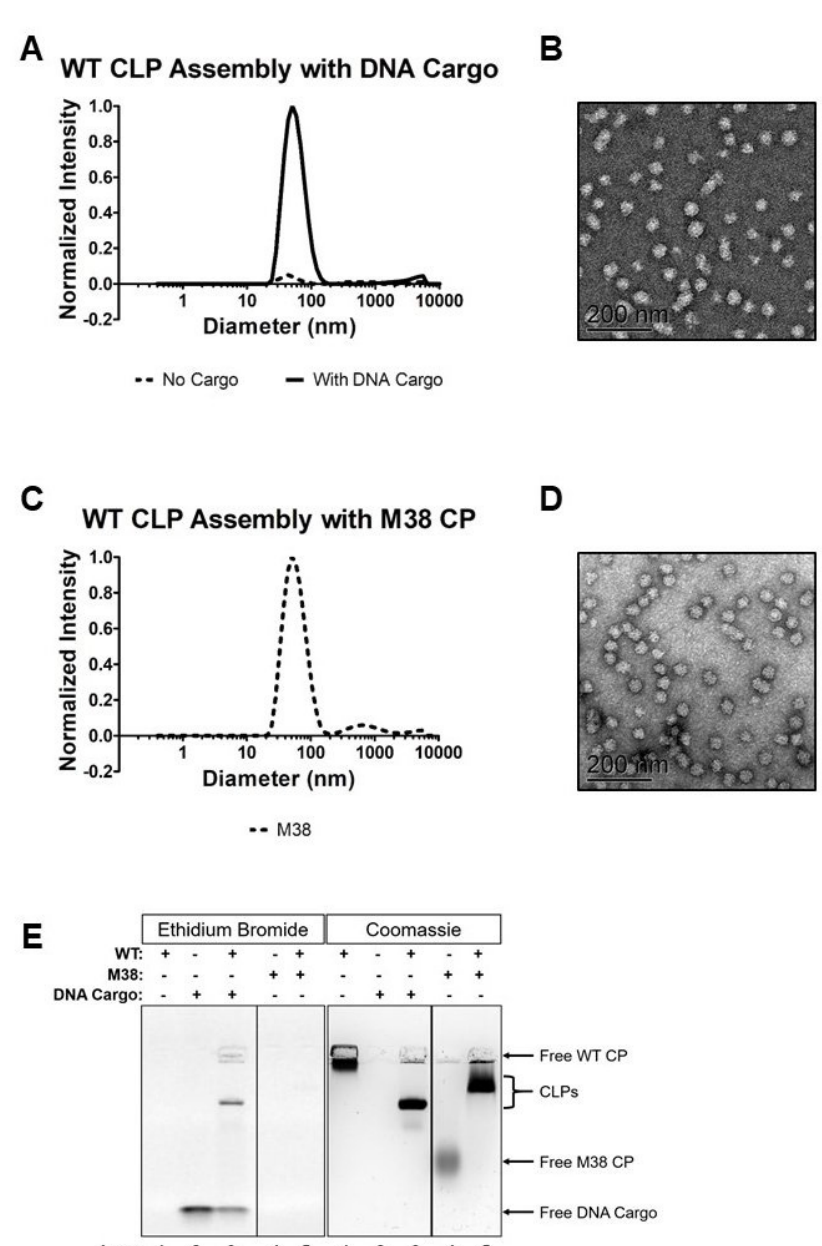
Figure 2. M38 capsid protein (CP) can replace DNA cargo during core-like particles (CLP) assembly with WT CP. ( A ) Assembly of WT + DNA cargo CLPs by dynamic light scattering (DLS) and ( B ) negative-stain transmission electron microscopy (TEM). ( C ) Assembly of WT + M38 CLPs by DLS and ( D ) negative-stain TEM. ( E ) Gel-shift analysis of the reactions in ( A , C ) plus the M38 CP- and DNA cargo-only controls. The DLS curves represent the average of at least four biological replicates and were normalized to the largest data point in the data set.